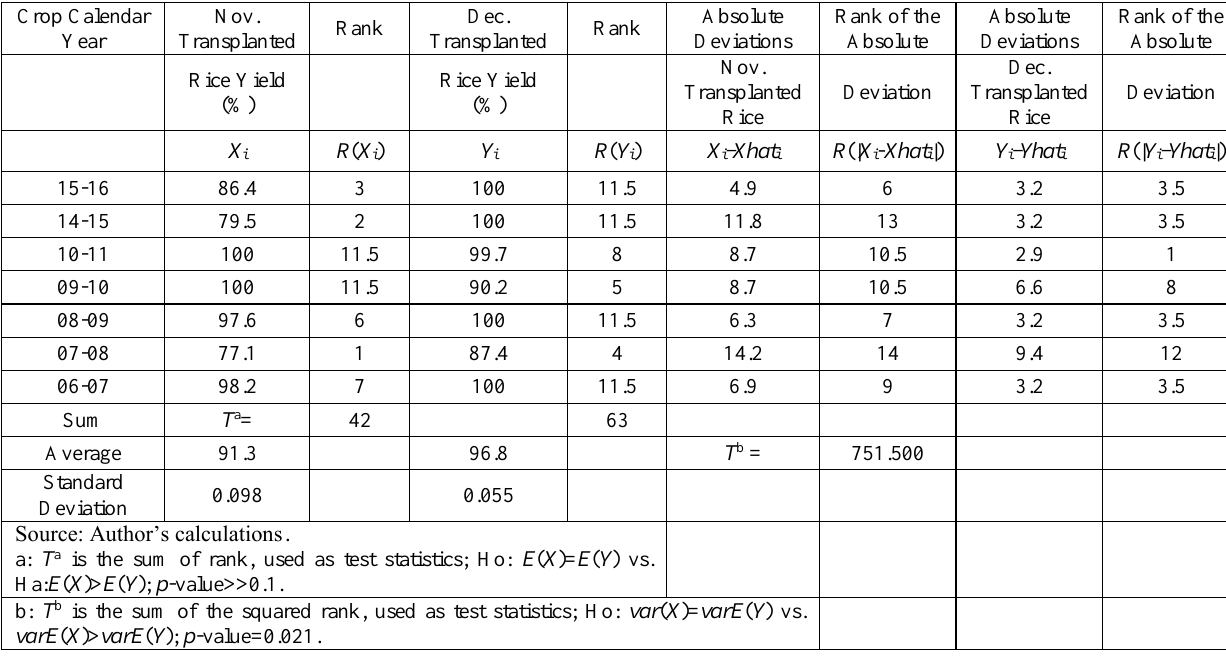
55.5 Average 56.4 47.3 1946.000 Standard Deviation 0.154 0.0838